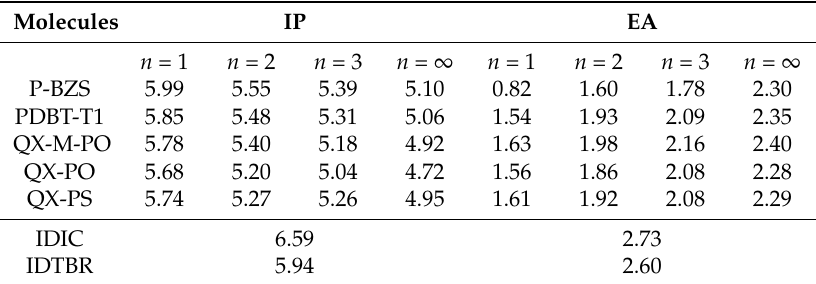
Table 4. The ionization potentials IP (eV) and electron affinities EA (eV) of the five polymers and of the NFAs IDIC,